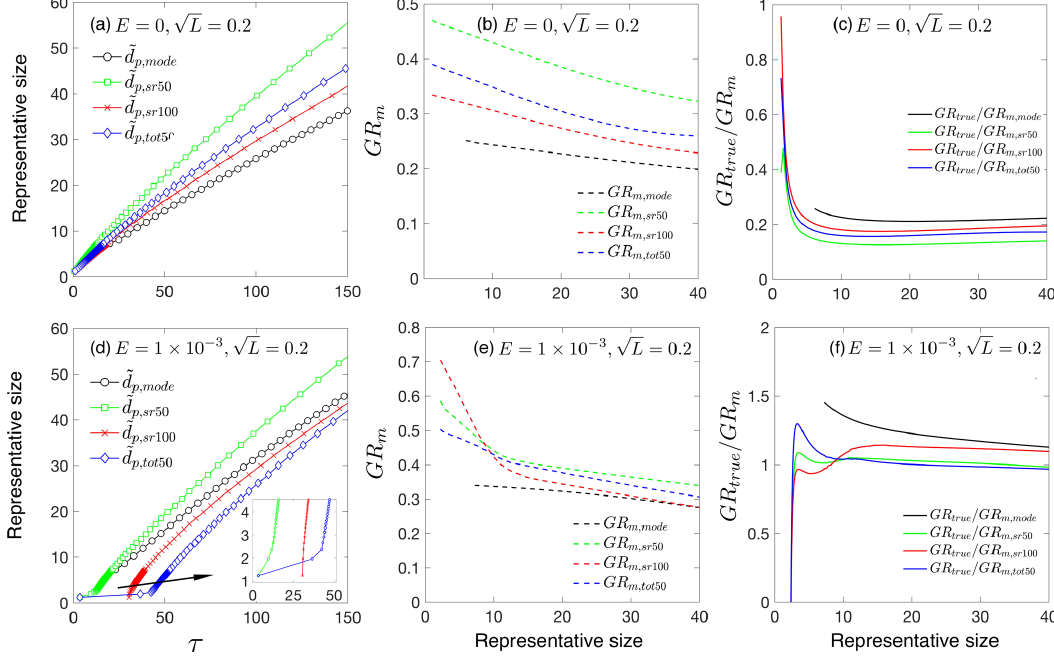
Figure 5. (a) e d p , mode , e d p , sr100 , e d p , tot50 and e d p , bin50 as functions of time. (b) Measured growth rate GR m , mode , GR m , sr50 , GR m , sr100 and GR m , tot50 as functions of representative sizes. (c) Ratio of true growth rate to measured growth rate, GR true / GR m . Panels (a) – (c) are for √ L = 0 . 2. Panels (d) – (f) show the same quantities as are shown in panels (a) – (c) but with collision-controlled nucleation with E = 0 and E = 1 × 10 − 3